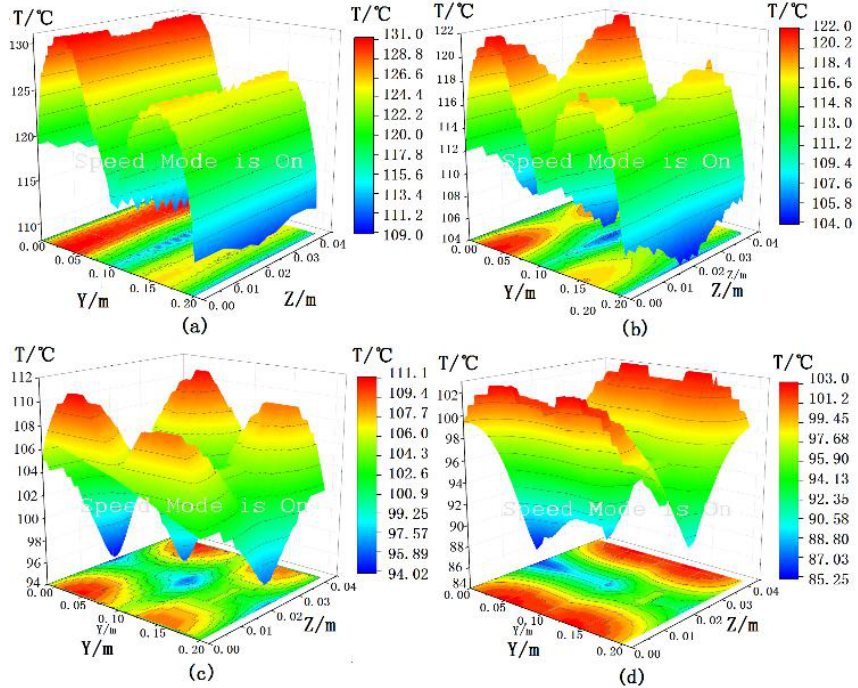
Figure 4. The main insulation axis–radial section temperature distribution under normal operating of the generator: ( a ) The main insulation axial–radial P 1 temperature distribution; ( b ) The main insulation axial-radial P 2 temperature distribution; ( c ) The main insulation axial–radial P 3 temperature distribution; ( d ) The main insulation axial–radial P 4 temperature distribution.